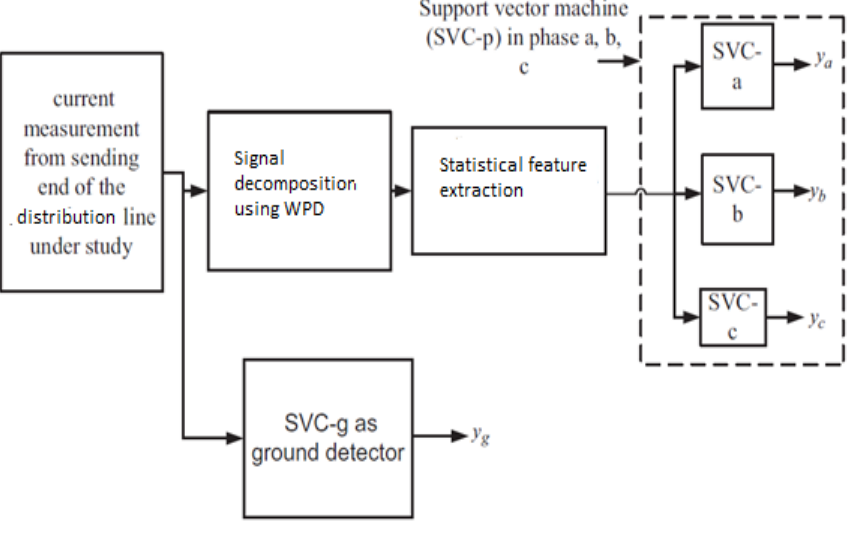
Figure 4. Fault classification taxonomy.